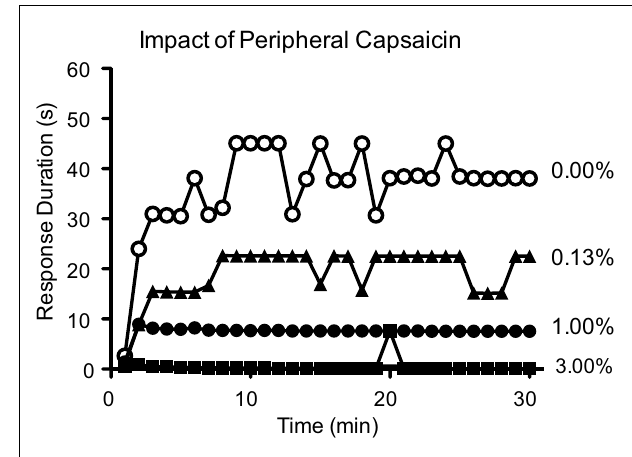
FIGURE 5 | Peripheral inflammation from capsaicin treatment induces a dose-dependent disruption in instrumental learning. Adapted from Hook et al.